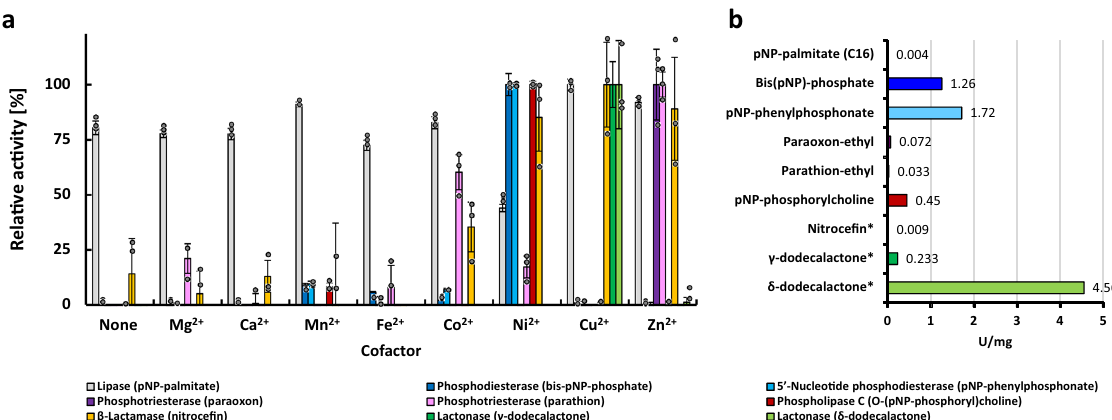
Fig. 3 Different divalent metal ions drive Igni18 ’ s enzymatic promiscuity. a Metal-dependency of Igni18 was measured with nine substrates representing activities catalyzed by M β Ls. All activities but lipase showed a strict metal dependency. Error bars represent the relative standard deviation ( n = 3 independent experiments). b Absolute activities measured in U mg − 1 under optimal conditions but the ones marked with an asterisk, which were measured at 40 °C (see Methods